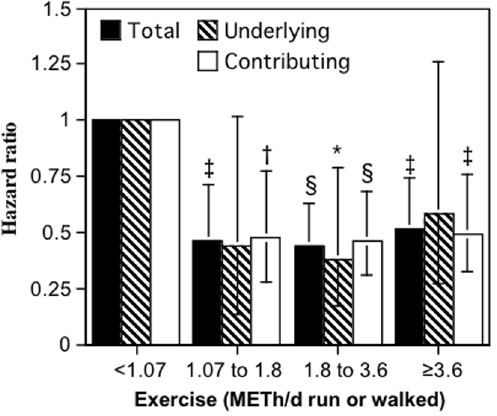
Figure 1. Relative risk of sepsis mortality by METh/d run or walked in 155,484 subjects during an average of